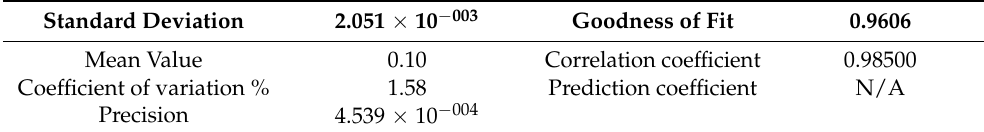
Table 13. Credibility analysis of the